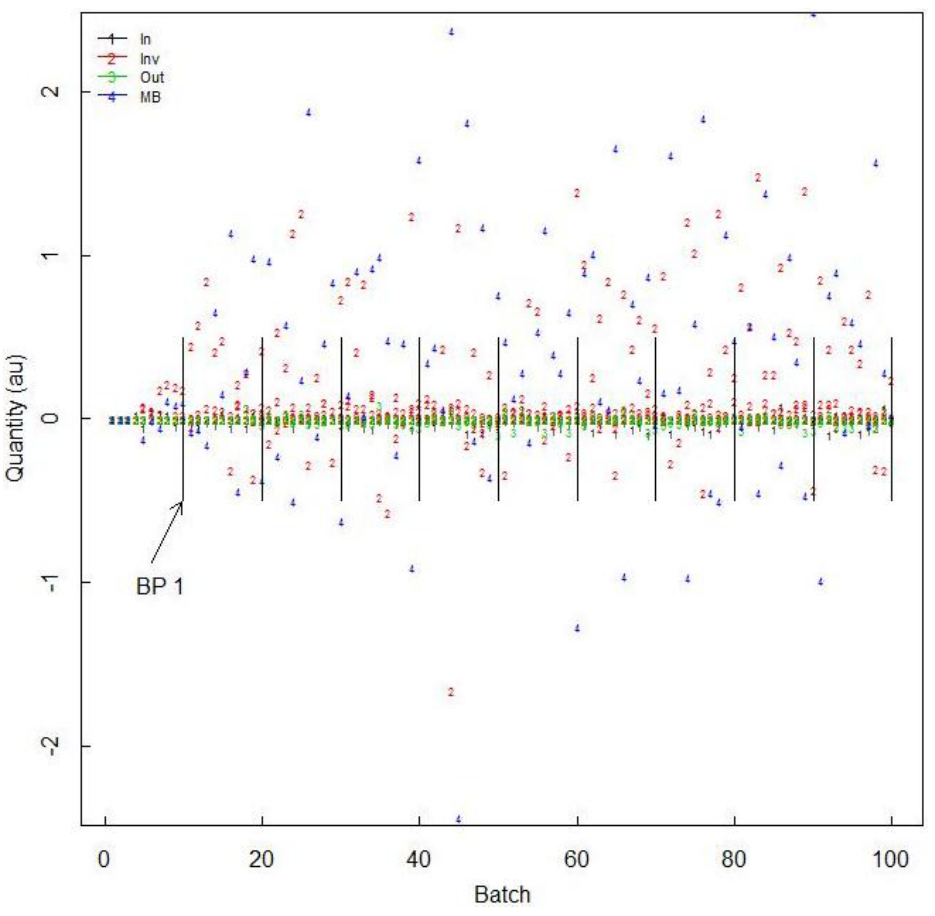
Figure 5. Daily material balances (“batches”) in ( a ); the estimated probability density of the MB value in ( b ); the autocorrelation function of the MB sequence in ( c ); and a lagged plot of the present MB versus the previous MB in ( d ).